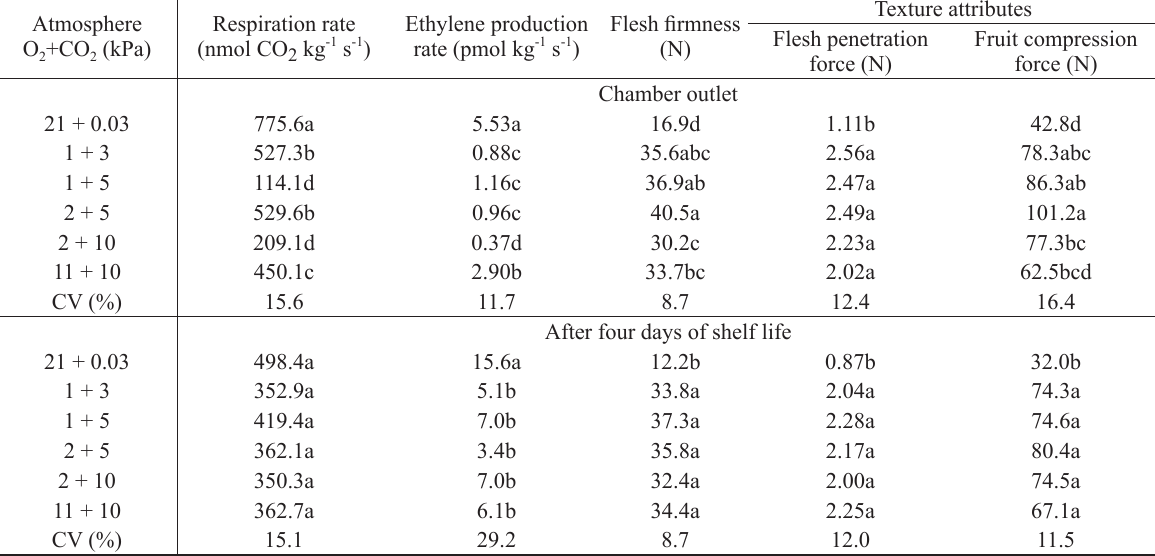
Respiration and ethylene production rates, flesh firmness and texture attributes in ‘Laetitia’ plums stored at 0.5°C under different atmospheres for 60 days and